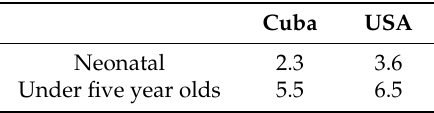
Table 2. Child mortality rates in Cuba and the USA.